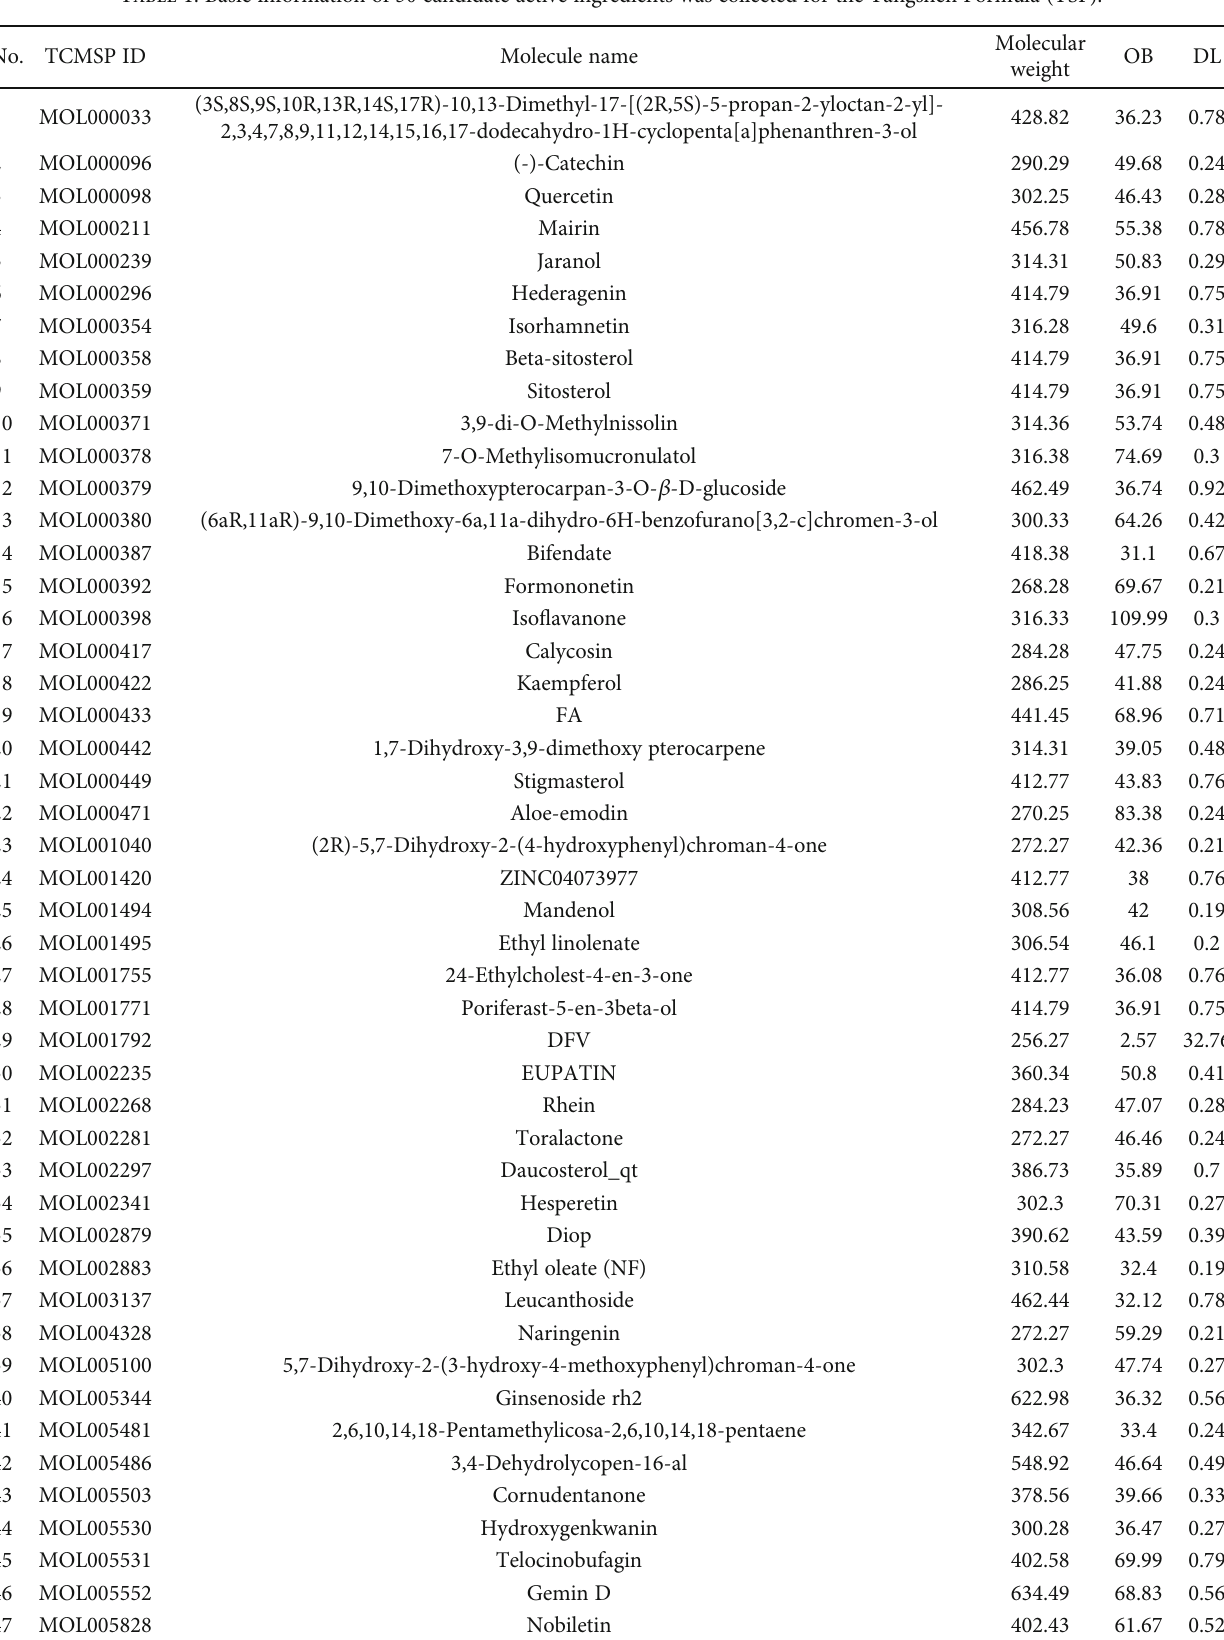
Table 1: Basic information of 50 candidate active ingredients was collected for the Tangshen Formula